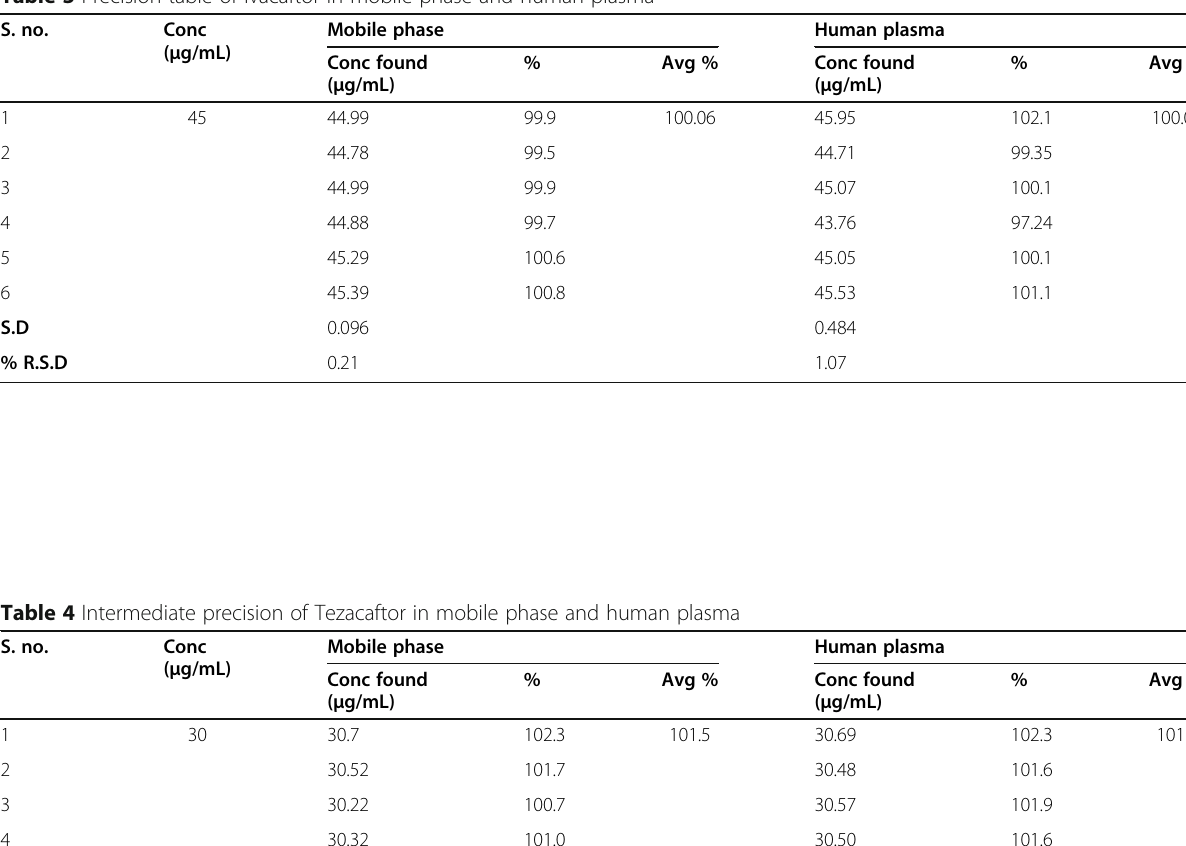
Table 3 Precision table of Ivacaftor in mobile phase and human plasma S. no.